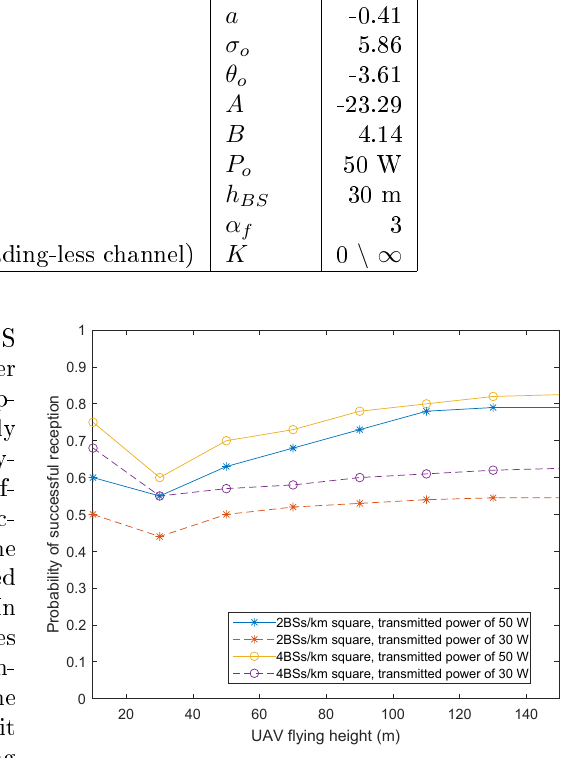
Fig. 3: UAV (cid:29)ying height to get successful reception with various transmitted